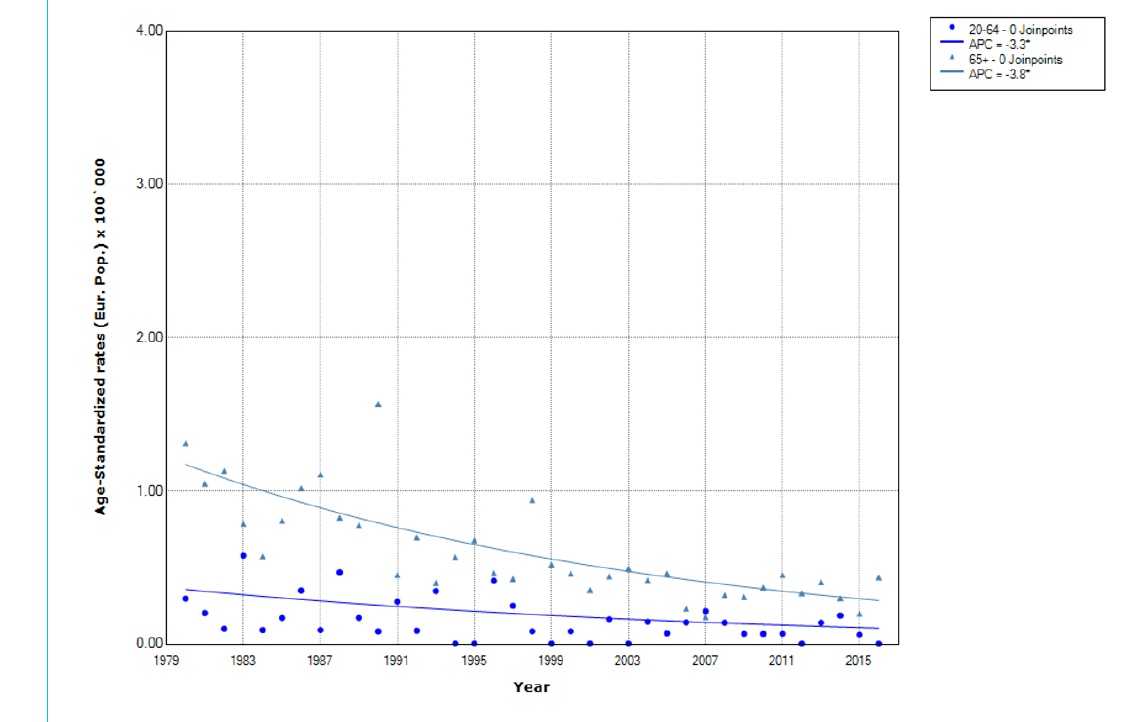
Figure 3: Trends in thyroid cancer mortality by age groups. Canton of Zurich 19802016. APC (annual percentage change). Age-standardised rates (European